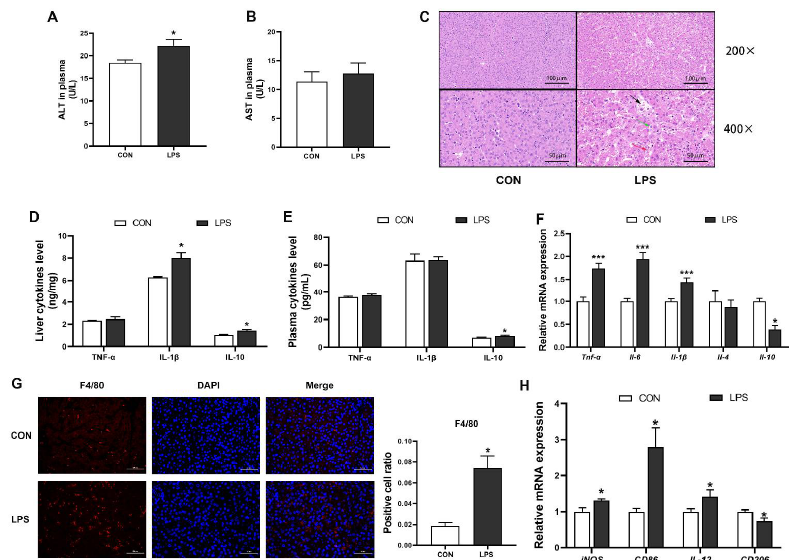
Figure 1. LPS led to inflammation and damage in the liver of piglets. ( A , B ) Activities of ALT and AST in plasma of piglets. ( C ) Liver slices were stained with hematoxylin and eosin to assess tissue injury. (H&E, ×200, scale bar = 100 μm; ×400, scale bar = 50 μm). The black arow indicates enlarged intercellular space; The green arow showed damaged cellular structures; The red arow showed blood cells stasis. ( D , E ) TNF-α, IL-1β, IL-10 concentrations in the liver and plasm were measured by ELISA. ( F ) The mRNA abundance of TNF-α, IL-6, IL-1β, IL-4, IL-10 were assessed in livers by RT-qPCR. ( G ) The liver sections were subjected to F4/80 immunofluorescence. DAPI was used for nuclear staining and a confocal laser scanning microscope (40× magnification) with Z-scan analysis. Scale bar = 50 μm. The ratio of F4/80-positive cells were quantified by ImageJ analysis. ( H ) the mRNA levels of iNOS, CD86, IL-12 and CD206 were measured in the total liver by RT-qPCR. n = 4−6 per group. Error bars represent the mean ± SEM. * represents significant differences between the CON group and the LPS group; * p < 0.05, *** p < 0.001.